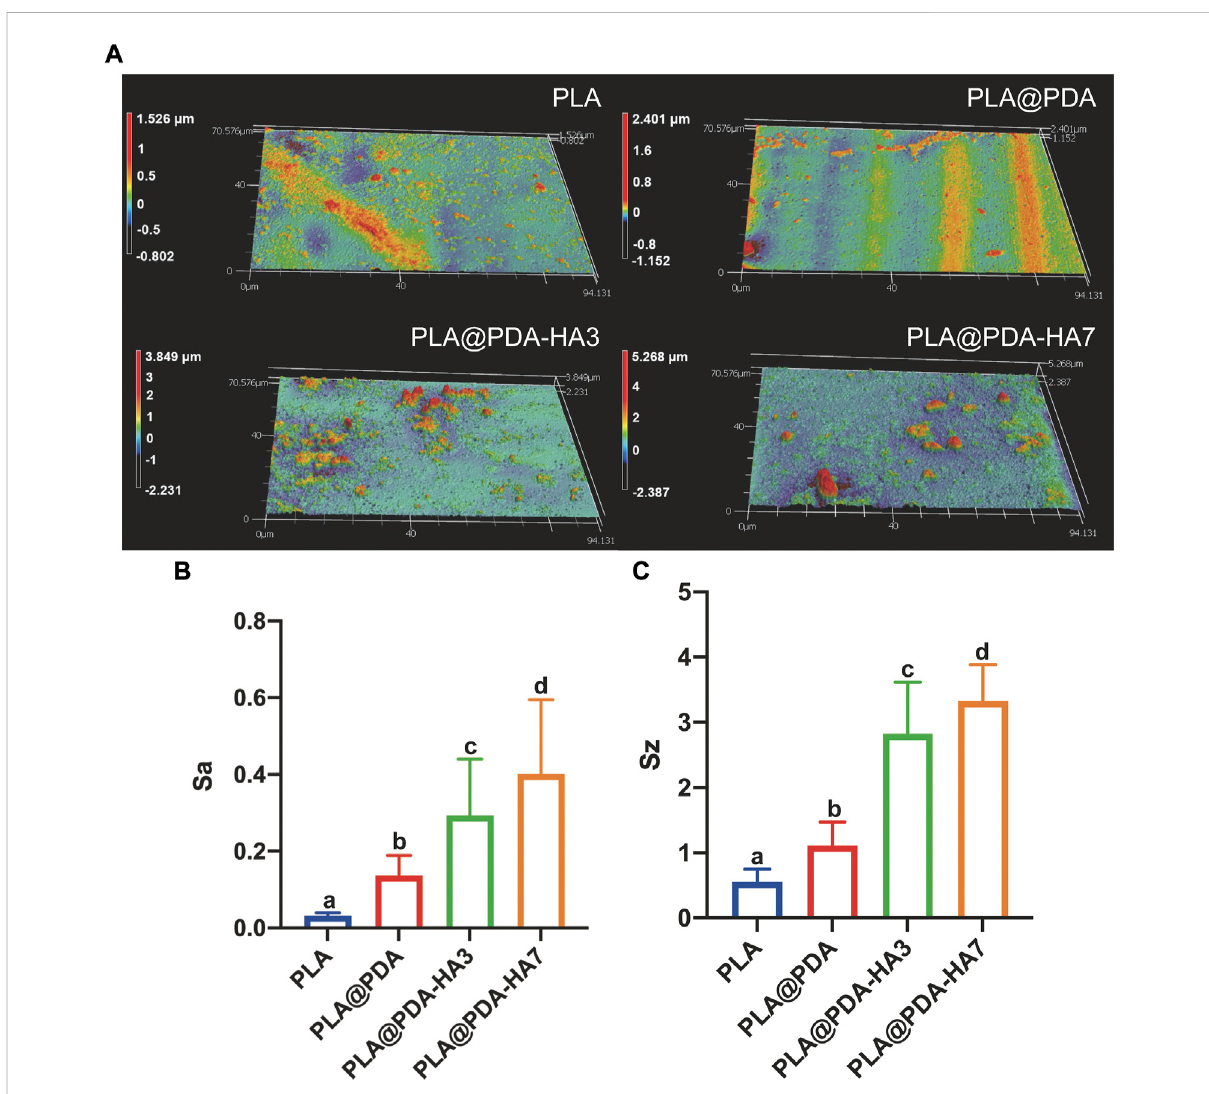
FIGURE 4 Surface roughness evaluation of PLA, PLA@PDA, PLA@PDA-HA3, and PLA@PDA-HA7 scaffolds. (A) Representative 3D surface topography of each scaffold. (B) Corresponding Sa (arithmetic mean height) and (C) Sz (maximum height). Dissimilar letters indicate statistical differences between groups ( n = 3, p <